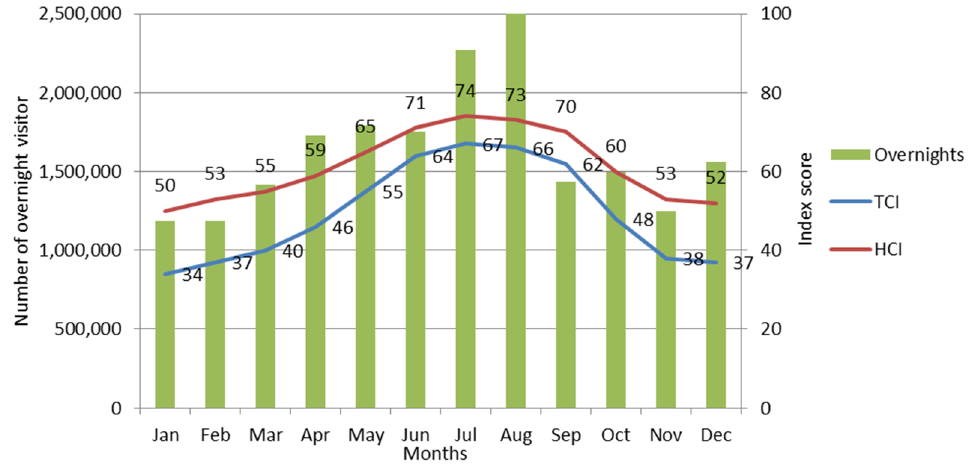
Figure 2. Comparison of Holiday Climate Index (HCI:Urban) and Tourism Climate Index (TCI) rating scores with monthly tourist overnights in Parisian hotels from 2000 to 2010.